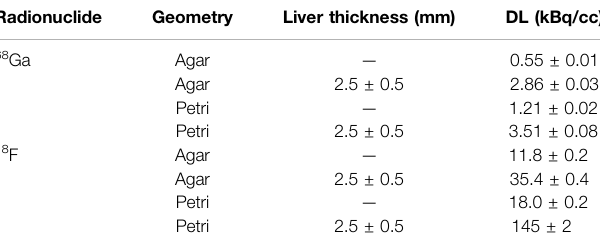
TABLE 2 | Detection limits (SNR (cid:1) 2) for 68 Ga and for 18 F in air and at 2.5 mm depth in the